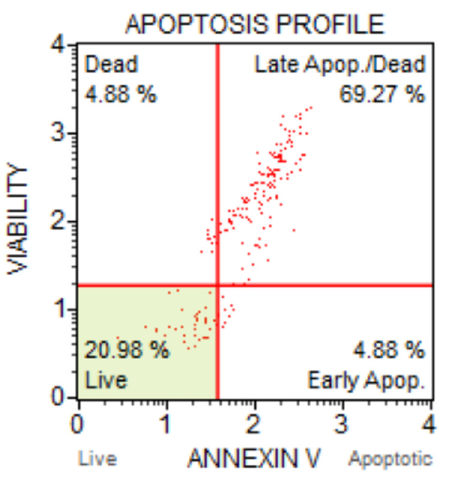
Figure 6. Treatment of the C6 cell line with compound 5f for 24 h via quantification of apoptotic cells via the flow cytometric analysis.